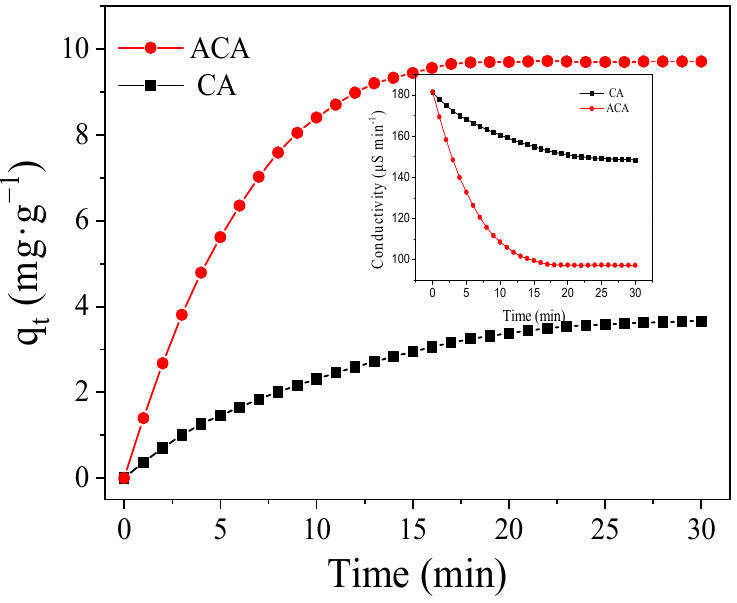
Figure 2. Desalination performance of CA and ACA electrodes.